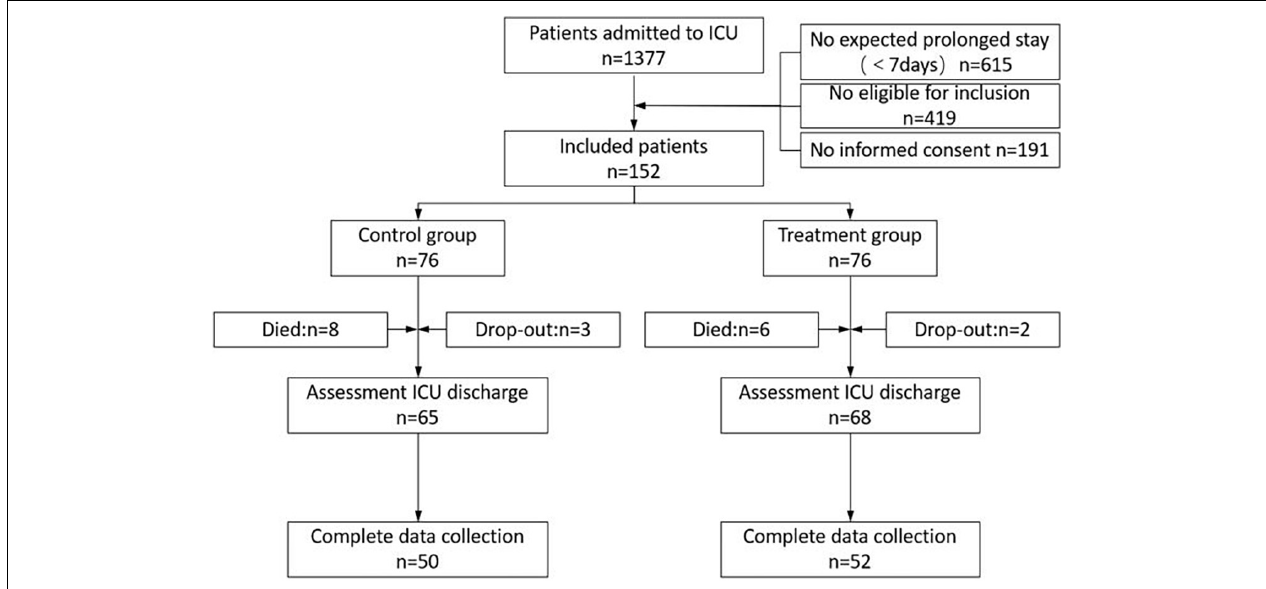
FIGURE 2 | Flow diagram of the patients admitted to this